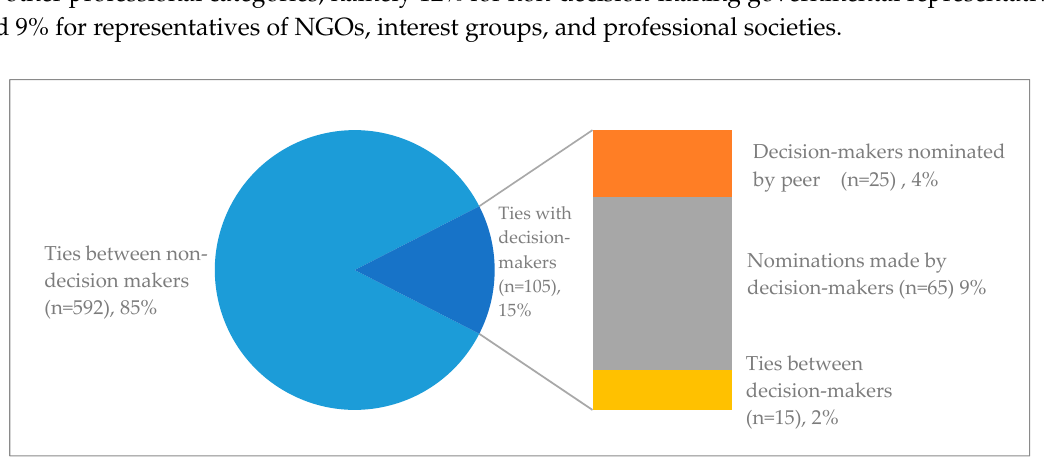
right bar depicts a further subdivision of type of direct ties with decision-makers (in-degree, out-degree, and tie between decision-makers).